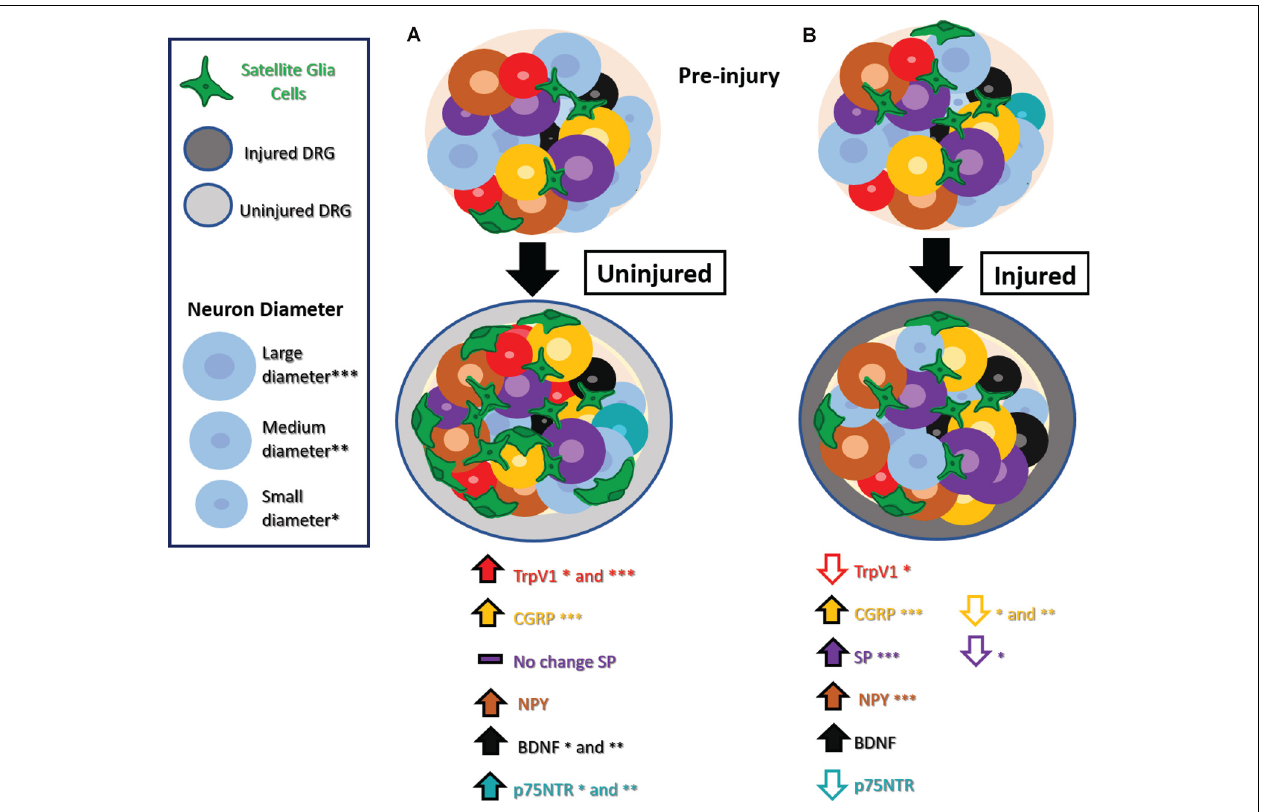
FIGURE 1 | Phenotype switching and other molecular changes in uninjured sensory neurons after nerve injury. (A) Uninjured dorsal root ganglion (DRG) neurons exhibit increased TrpV1 in small and medium-diameter neurons, CGRP in large-diameter neurons, NPY, BDNF in small- and medium-diameter neurons, and no significant changes in SP. Small- and medium-diameter neurons display increases in p75NTR as well. There is also an increase in satellite glial cells (SGCs). (B) Injured DRG neurons show decreased TrpV1 in small-diameter neurons, decreased CGRP in small- and medium-diameter neurons decreased SP in small-diameter neurons, and decreased p75NTR. Injured DRG neurons show increased BDNF, and injured large-diameter neurons show increased CGRP, SP, and NPY. An increase in SGCs appears in injured DRG as well. Abbreviations: TrpV1, transient receptor potential vanilloid 1; CGRP, calcitonin gene-regulated peptide; SP, substance P; NPY, neuropeptide Y; BDNF, Brain-derived neurotrophic factor; p75NTR, neurotrophin receptor p75. Asterisks denote cell diameter size, the absence of these indicate no reported differences between cells of different